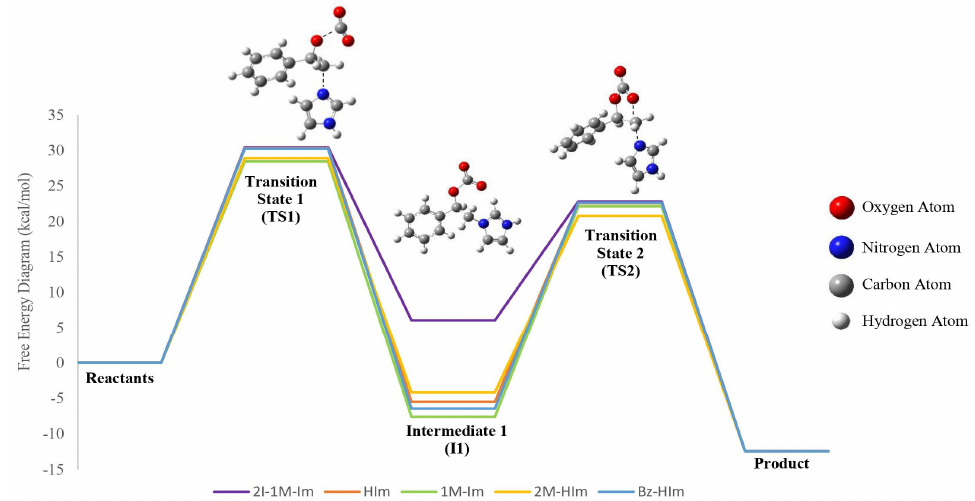
Figure 3. Free energy diagram (kcal/mol) reaction 1 with different catalysts; Imidazole (orange), 1- Methylimidazole (green), 2-Methylimidazole (yellow), Benzimidazole (blue), and 2-Iodo-1-Methylimidazole (purple). HIm has been selected as the representative Lewis base for structure